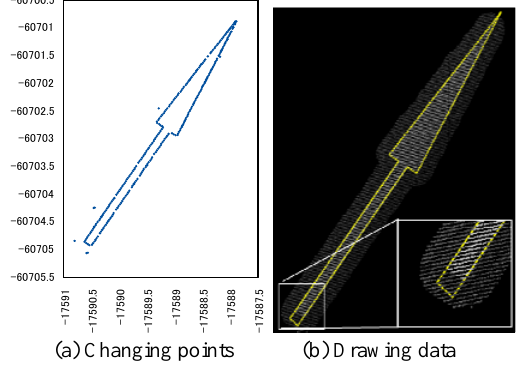
Figure 22. Filter size=5